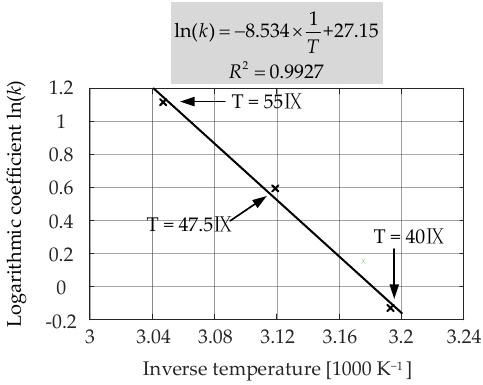
Figure 20. Arrhenius equation for determining the temperature dependence of capacity fade (at 50% SOC level).